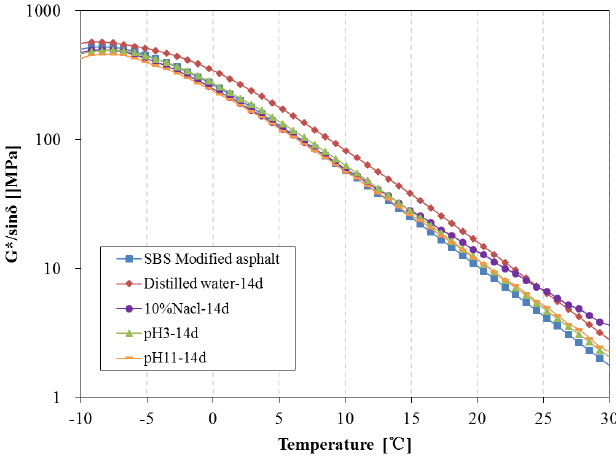
Figure 16. Rutting parameter of SBS modified asphalt before and after 14 days immersion.